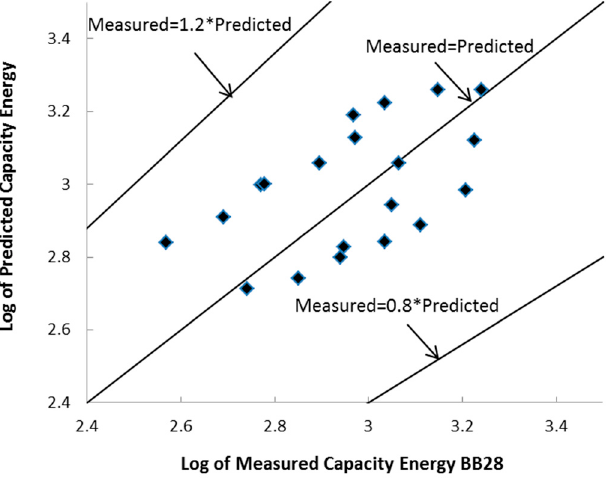
Figure 5. Capacity energy predicted by RSM equation on the basis of the Box-Behnken (BB) design of experiment (DOE) and the second ANN model versus the measured values of laboratory tests.